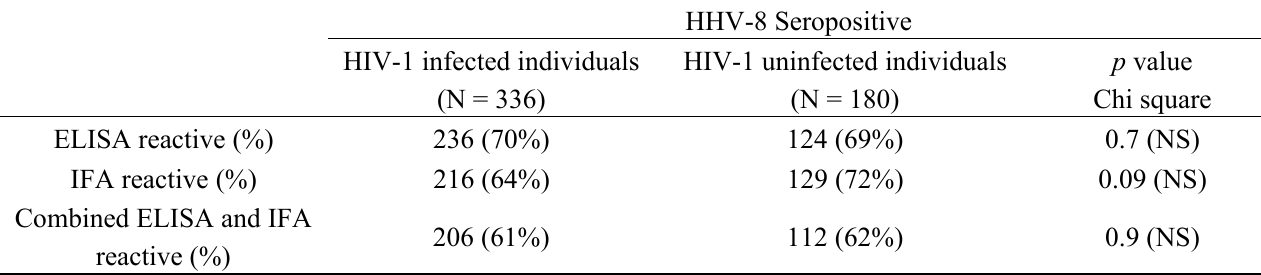
Table 1. Seroprevalence of HHV-8 in HIV infected and uninfected individuals in